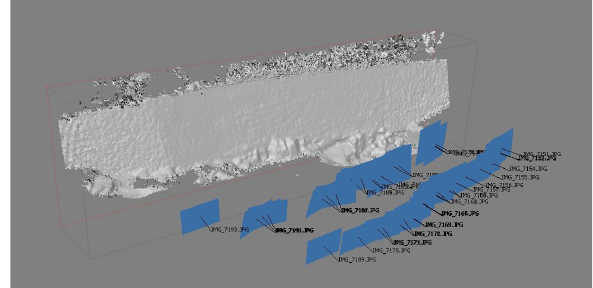
Figure 4. View of the dense point cloud of one sectors of the ​ interior of the walls and images orientation.